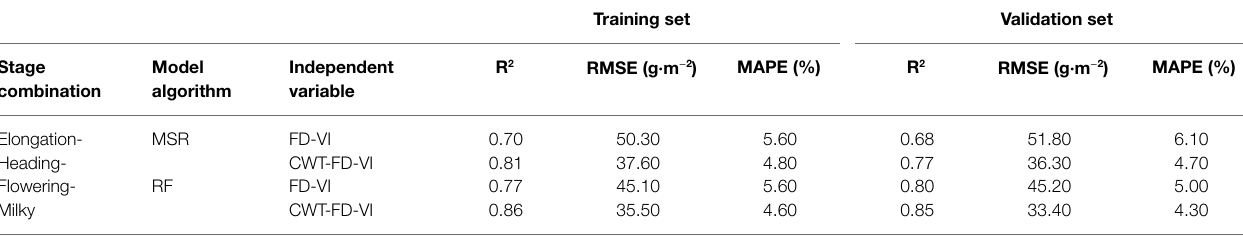
TABLE 7 | Comparison of the two modeling